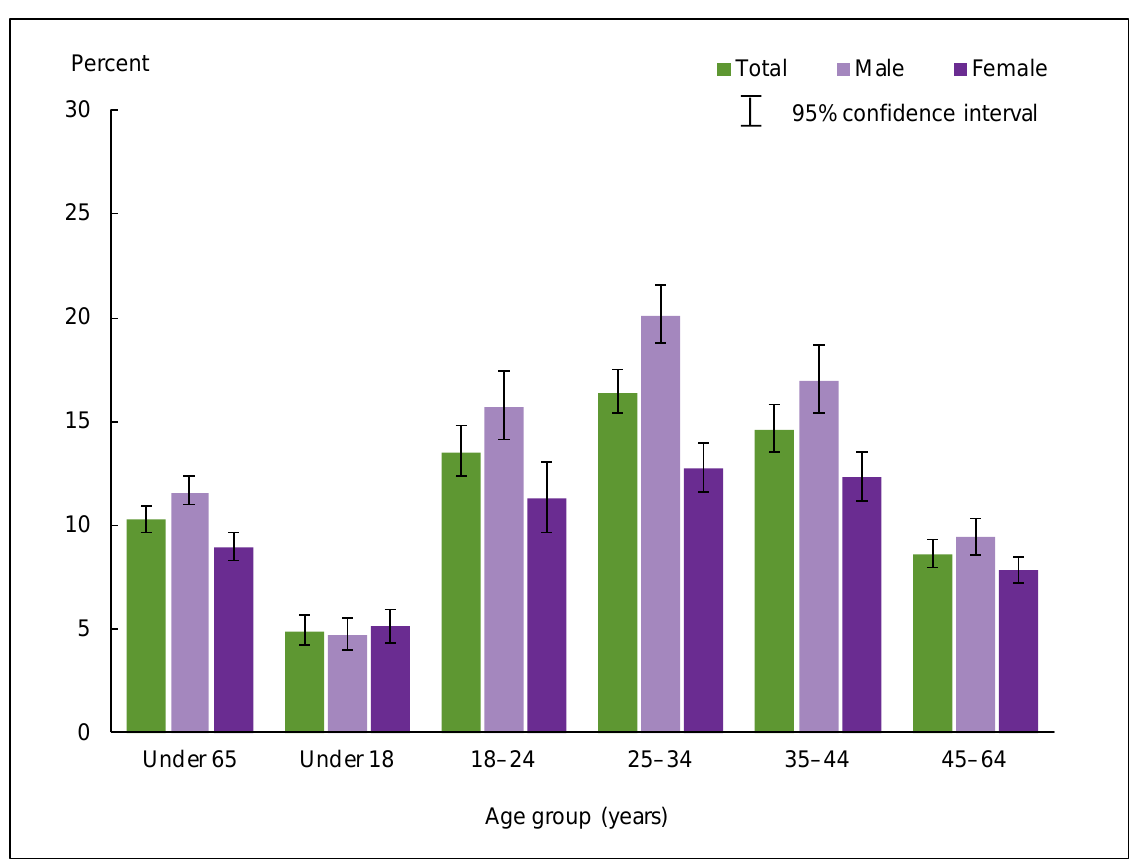
Figure 1.2. Percentage of persons under age 65 without health insurance coverage at the time of interview, by age group and sex: United States,